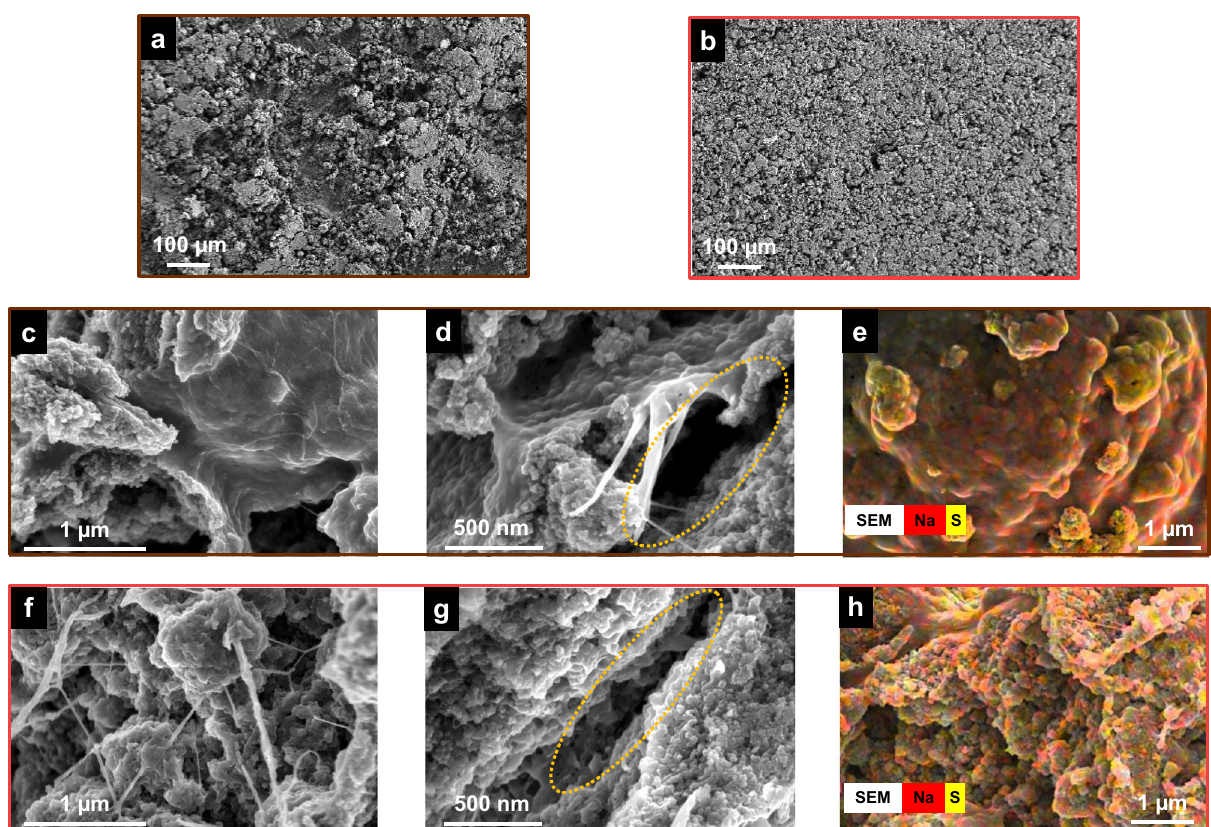
Fig. 8 Ex situ post-mortem of lithium metal anode and sulfur cathode after an intense cycling regime. Top-view SEM images of lithium metal coupling with a CMC cathode and b CMC/G cathode. Cross-sectional observation and elemental mapping of c – e CMC cathode and f – h CMC/G cathode at full charge